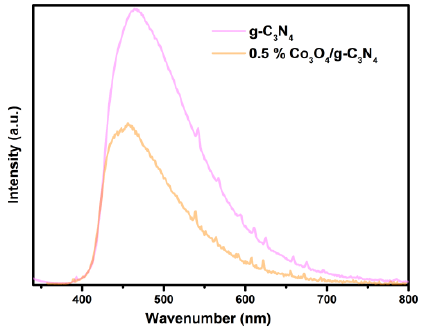
Figure 8. Steady-state photoluminescence spectra of fabricated photocatalysts.